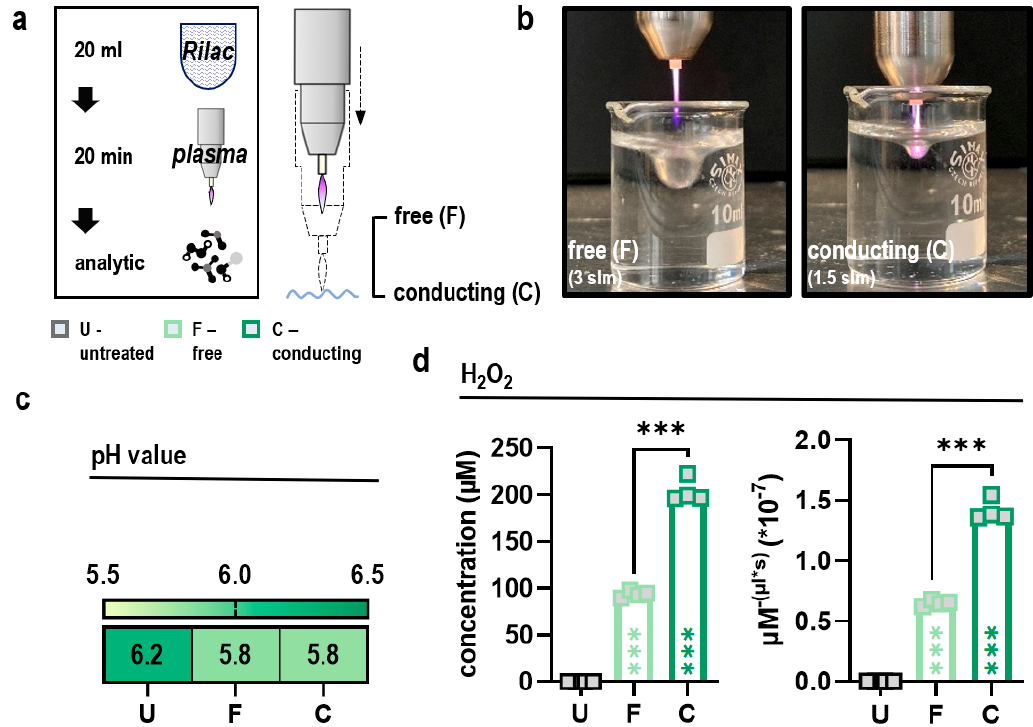
Figure 1. Conducting gas plasma treatment augments the delivery of hydrogen peroxide into Ringer’s lactate solutions. ( a ) Schematic overview of gas plasma treatment procedure of Ringer’s lactate (Rilac) in free (F) and conducting mode (C) and subsequent liquid analysis; ( b ) gas plasma treatment in free and conducting mode; ( c ) pH in gas plasma-oxidized Ringer’s lactate (oxRilac); ( d ) absolute concentration of hydrogen peroxide (H 2 O 2 ) in oxRilac solutions after treatment in free or conducting mode and delivery thereof in liquids per microliters and seconds. Heat map shows medians. Bar graphs show medians and individual values. Statistical analysis was conducted using one-way analysis of variance (ANOVA) and Tukey’s post hoc testing (*** p < 0.001). slm = standard liters per minute; U = untreated; F = free mode; C = conducting mode.